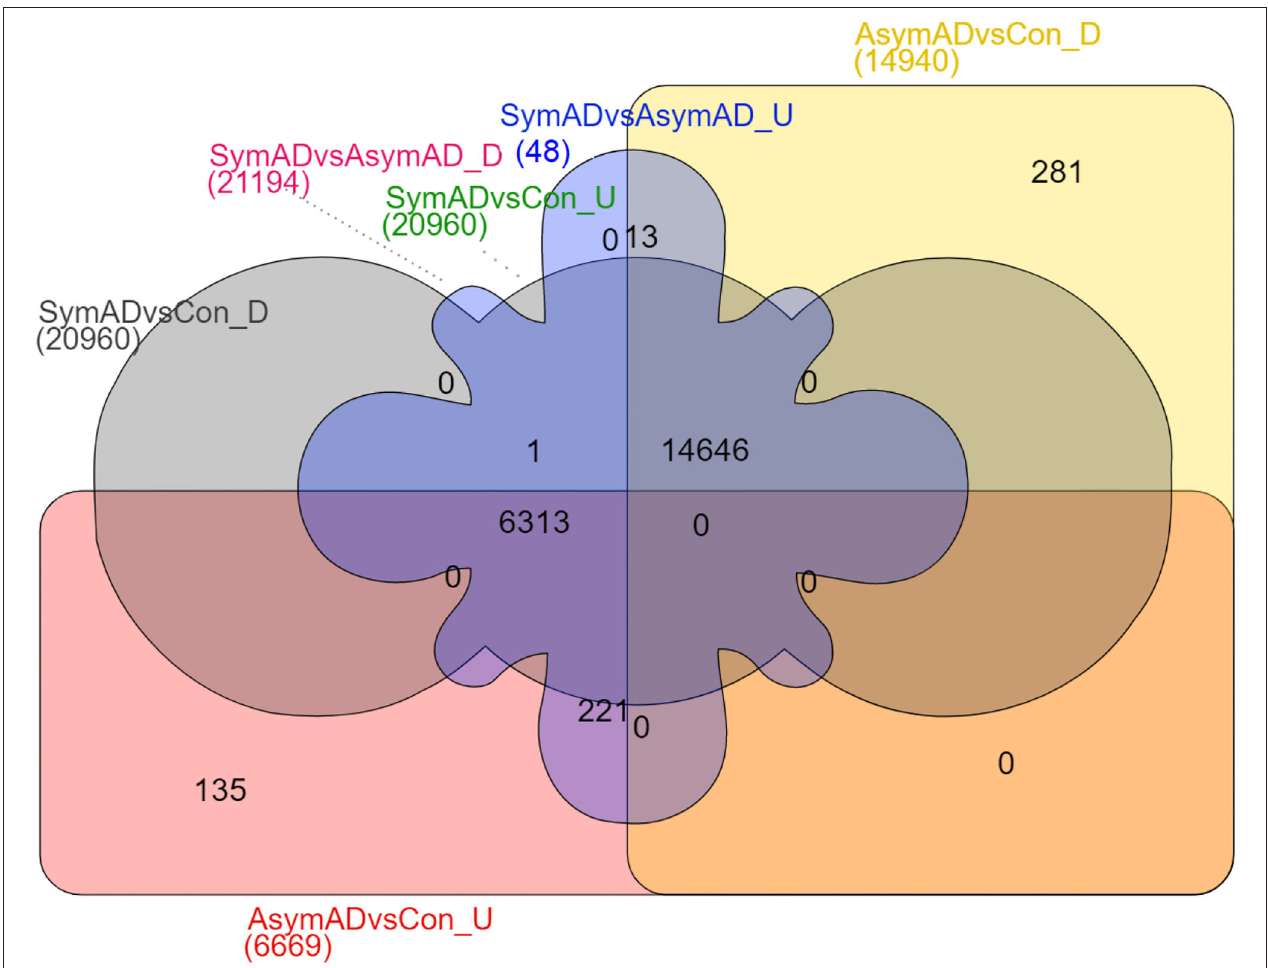
FIGURE 3 | Venn diagram comparing identified upregulated and downregulated DEGs of AsymAD vs. control samples, symAD vs. control samples, and symAD vs. AsymAD